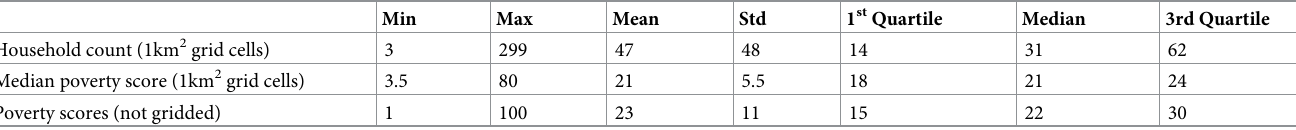
Table 3. Descriptive statistics of PSC observations and target layer (1km 2 grid